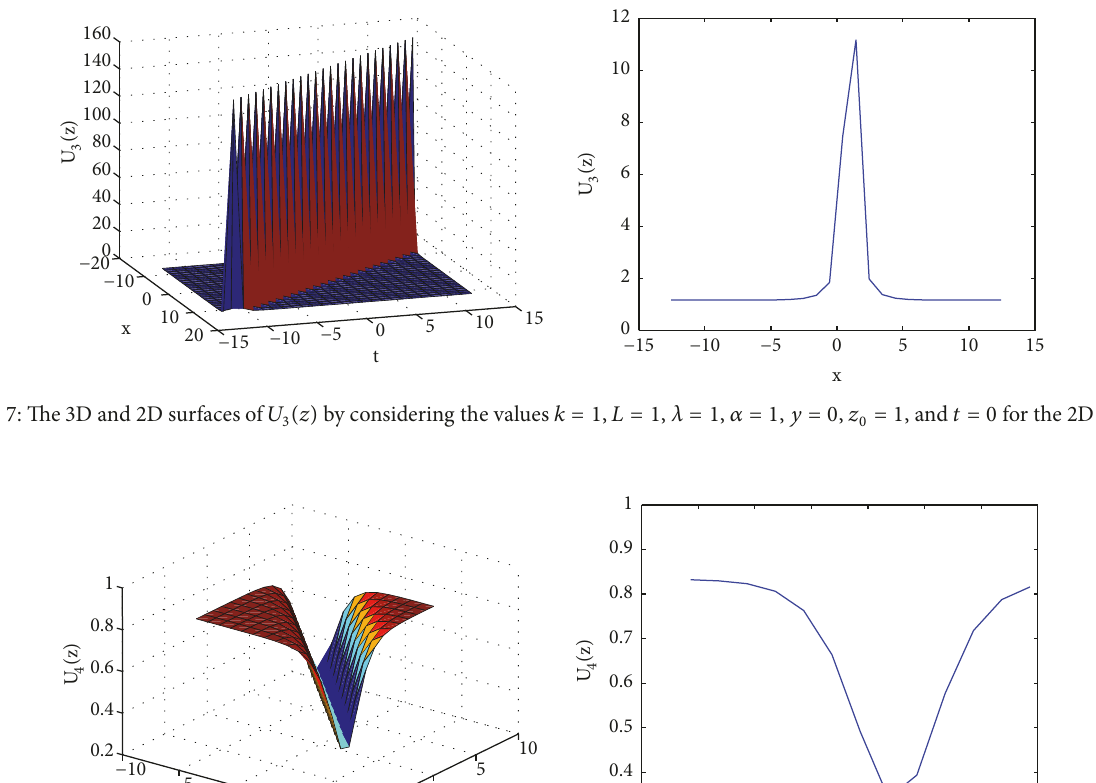
[41]. Therefore, more NLDEs in mathematical physics can be solved by the extended complex method. Using the indeterminate forms of the solutions, we are able to seek meromorphic solutions 𝑈(𝑧) for the differential equation with a pole at 𝑧 = 0 , and then we can derive meromorphic solutions 𝑈(𝑧 − 𝑧 0 ) , 𝑧 0 ∈ C , for the differential equation with an arbitrary